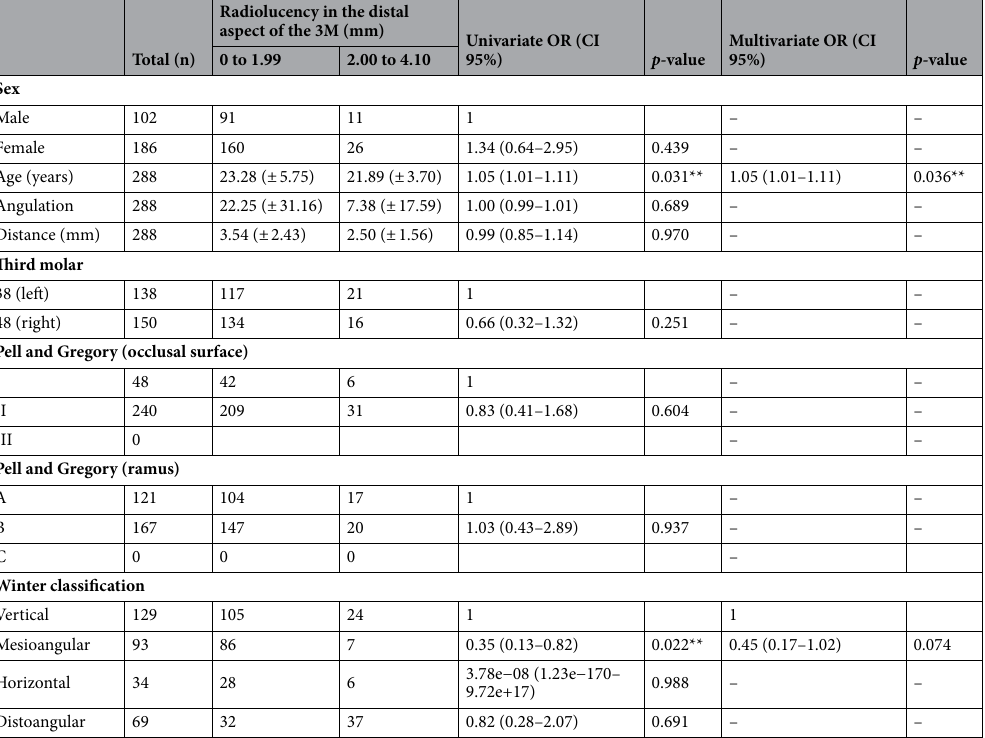
Table 2. Frequency distribution plus univariate/multivariate logistic regression model: radiolucency in the 3M distal and independent variables. Data are presented as n of subjects (%) or as mean ± SD. OR odds ratio, CI 95% 95% of confidence interval. *p < 0.20; **p <